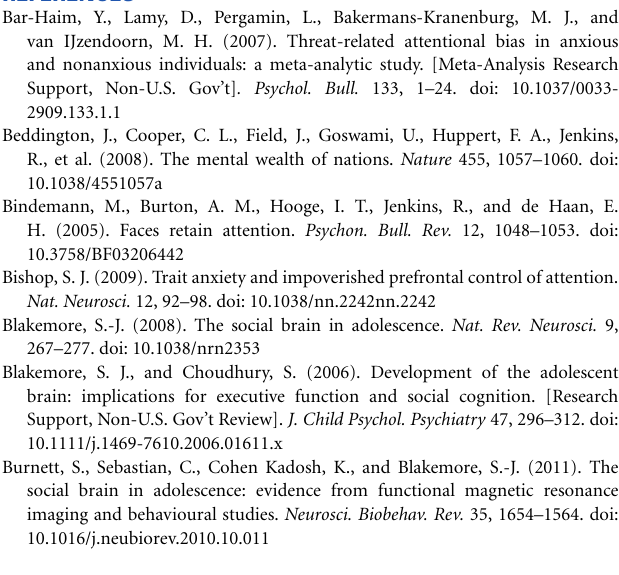
Table S1 | Analysis of variance (ANOVA) for the factors expression × Age